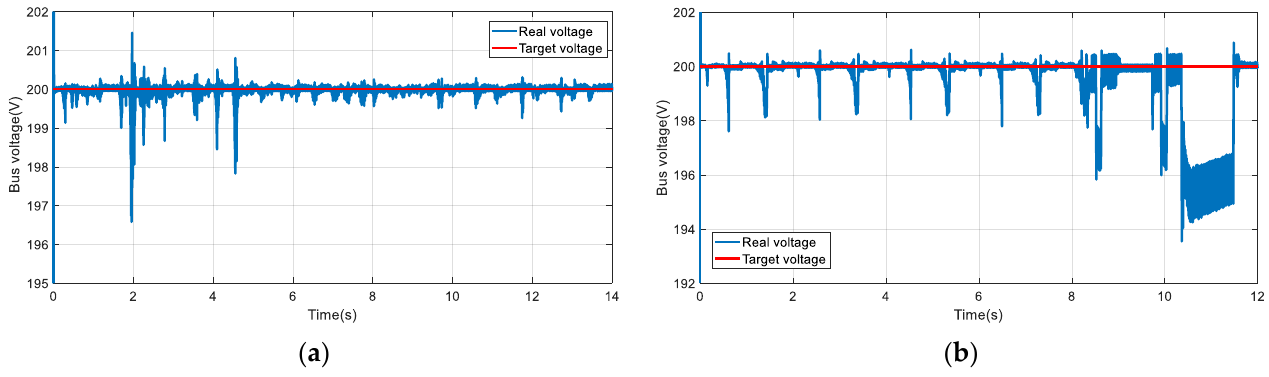
Figure 13. The tracking curves of the bus voltage: ( a ) UDDS cycle; ( b ) NEDC cycle.